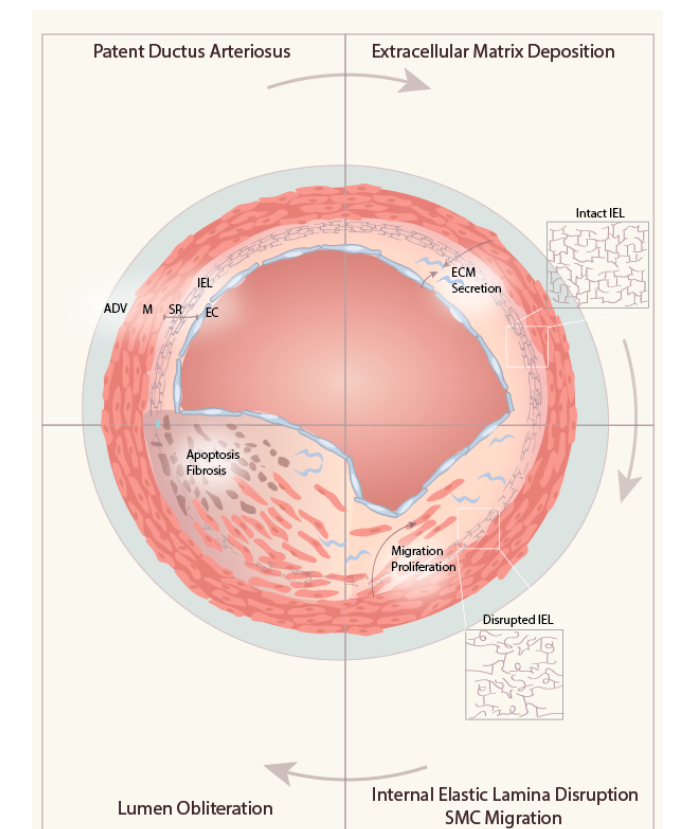
Figure 2. Sequential steps required for intimal thickening of ductus arteriosus closure. Complete